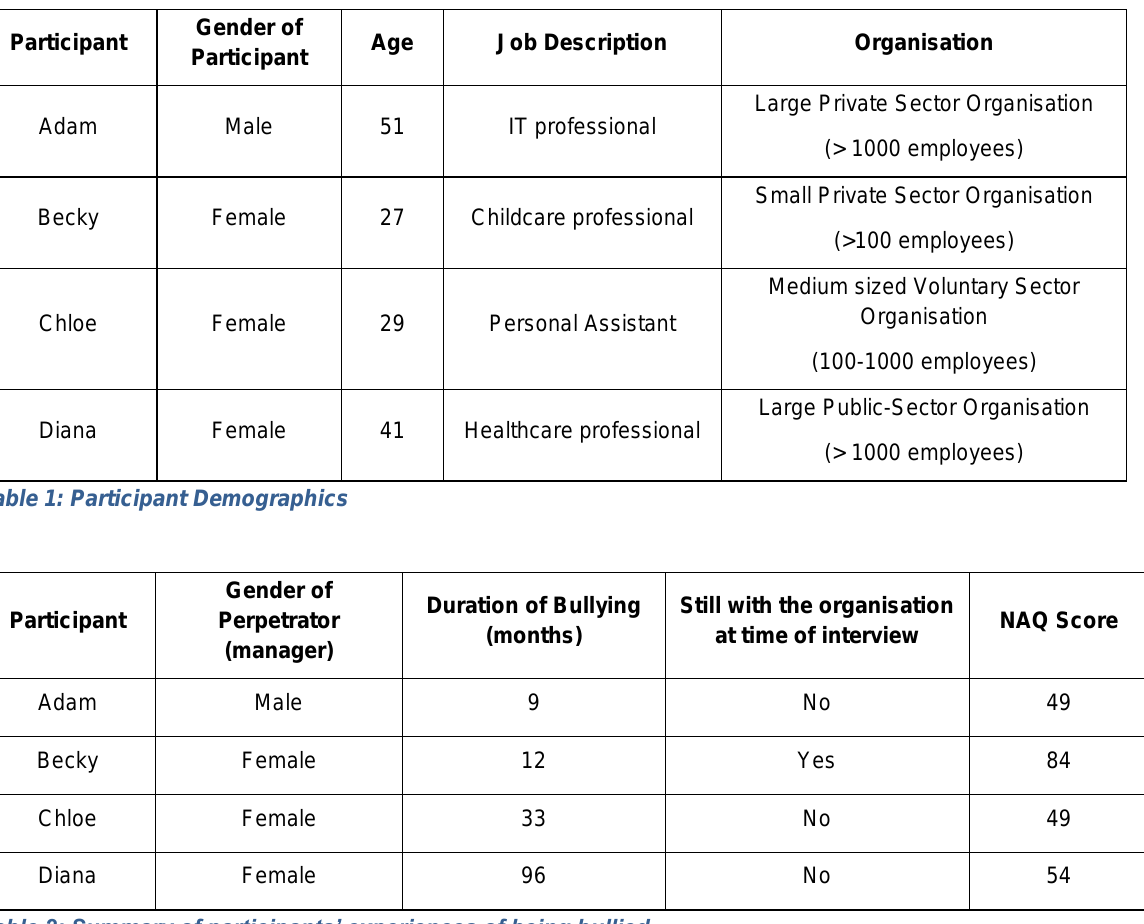
Table 2: Summary of participants’ experiences of being bullied.